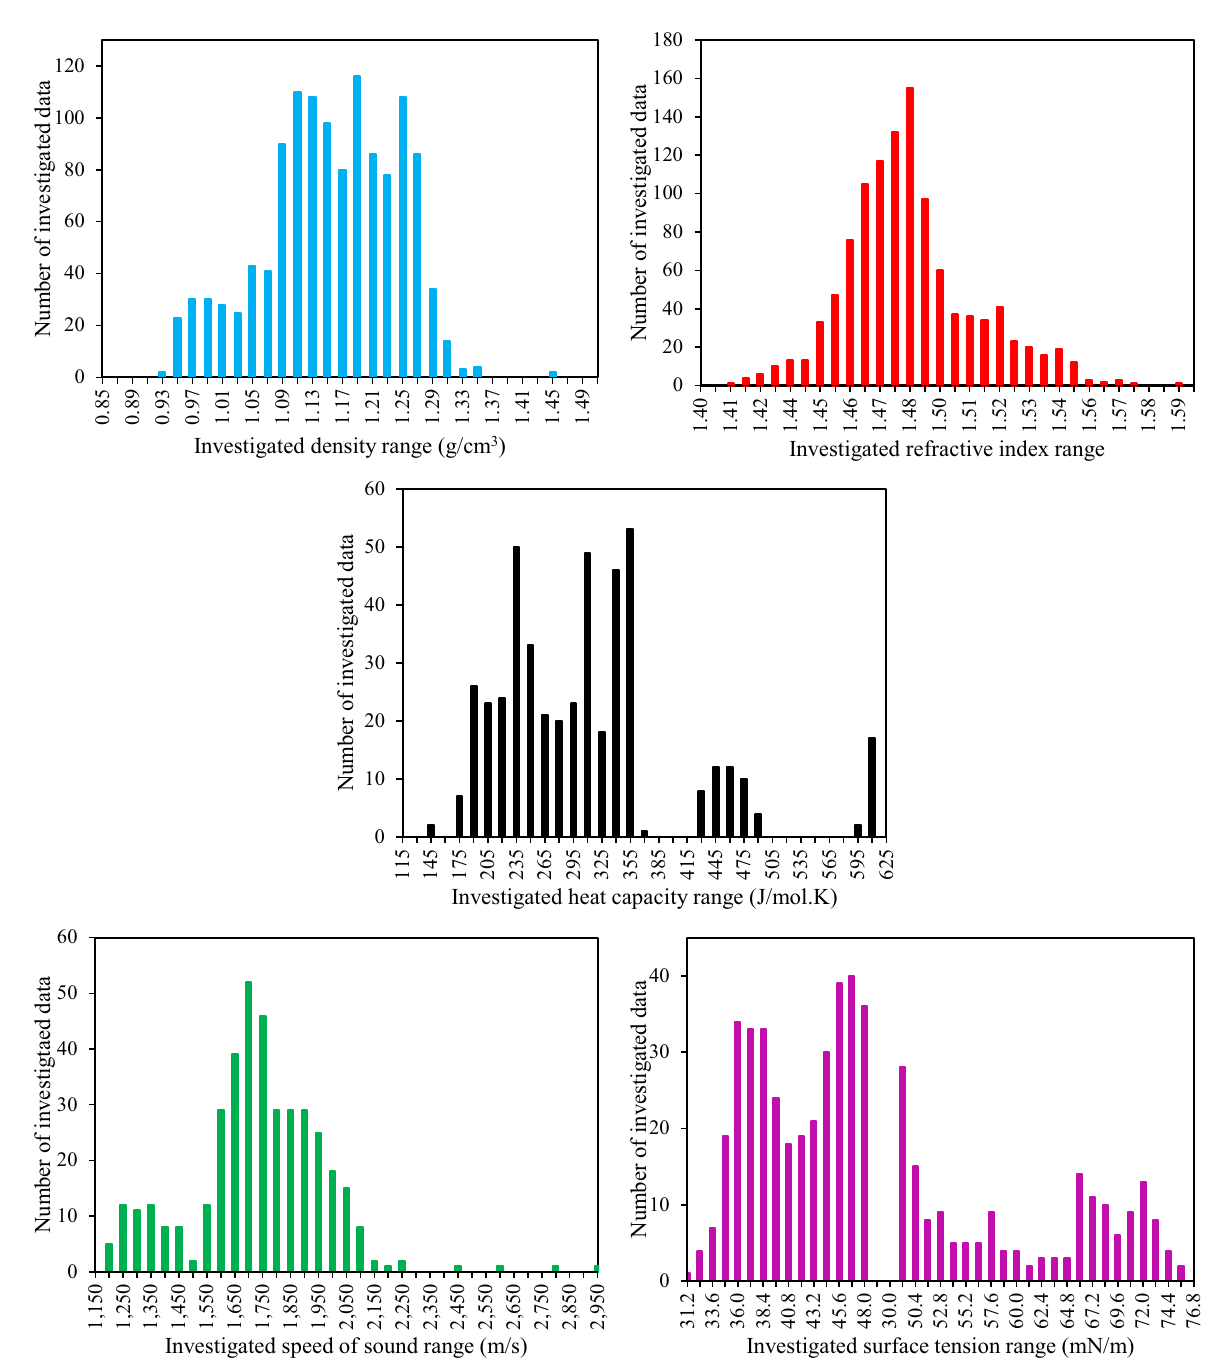
Figure 4. The ranges of investigated densities, refractive indices, heat capacities, speeds of sound and surface tensions and the corresponding data